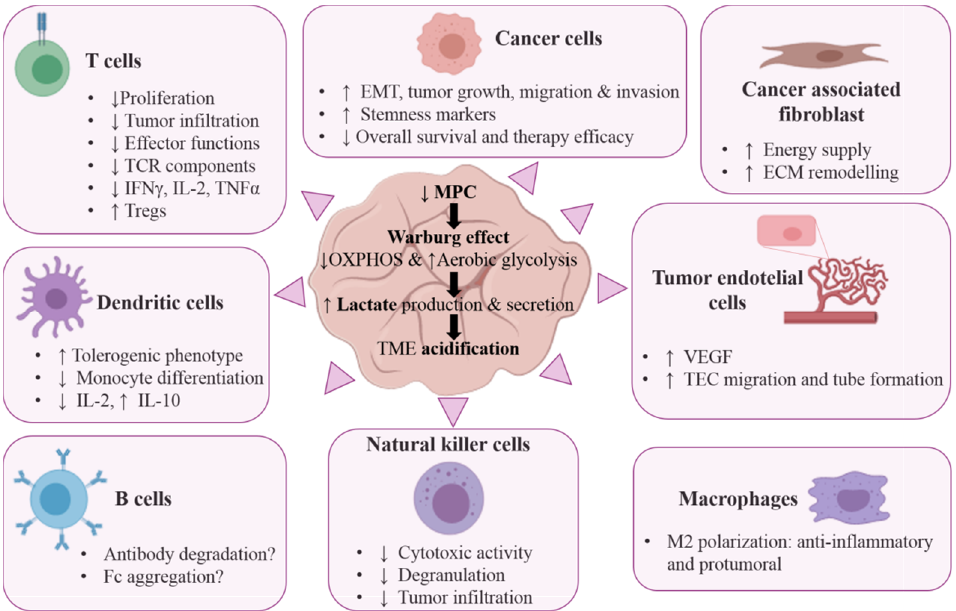
Figure 2. Overview of the impact of the Warburg effect caused by MPC loss, and the acidification of the tumor microenvironment (TME). Cancer cells undergo metabolic reprogramming from OXPHOS to aerobic glycolysis promoted by MPC loss/downregulation. This leads to the massive production of lactate, which is secreted into the TME, reducing the pH. These conditions promote the formation of new vasculature by vascular-endothelial growth factor (VEGF) signaling in tumor endothelial cells, favoring the growth of cancer-associated fibroblasts (CAFs) by providing lactate as a substrate for ATP production. They also affect different immune cell populations, causing